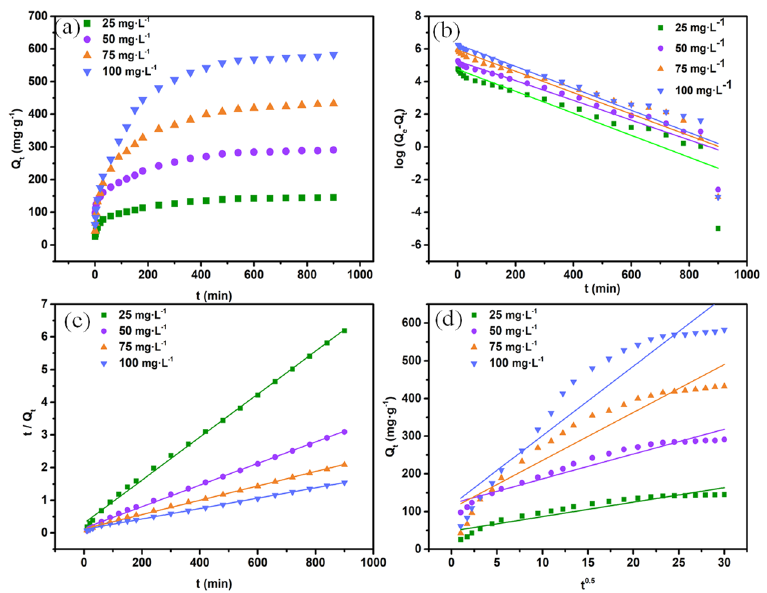
Figure 4. ( a ) Influence of contact time on the removal of Cr (VI) (pH = 2.0, 25° C); ( b ) plots of the pseudo-first-order kinetic adsorption model; ( c ) plots of the pseudo-second-order kinetic adsorption model; ( d ) plots of the intraparticle diffusion adsorption model. Table 1. Kinetic parameters of the adsorption of Cr (VI) onto the DAPFP biosorbent. Pseudo-First-Order Model